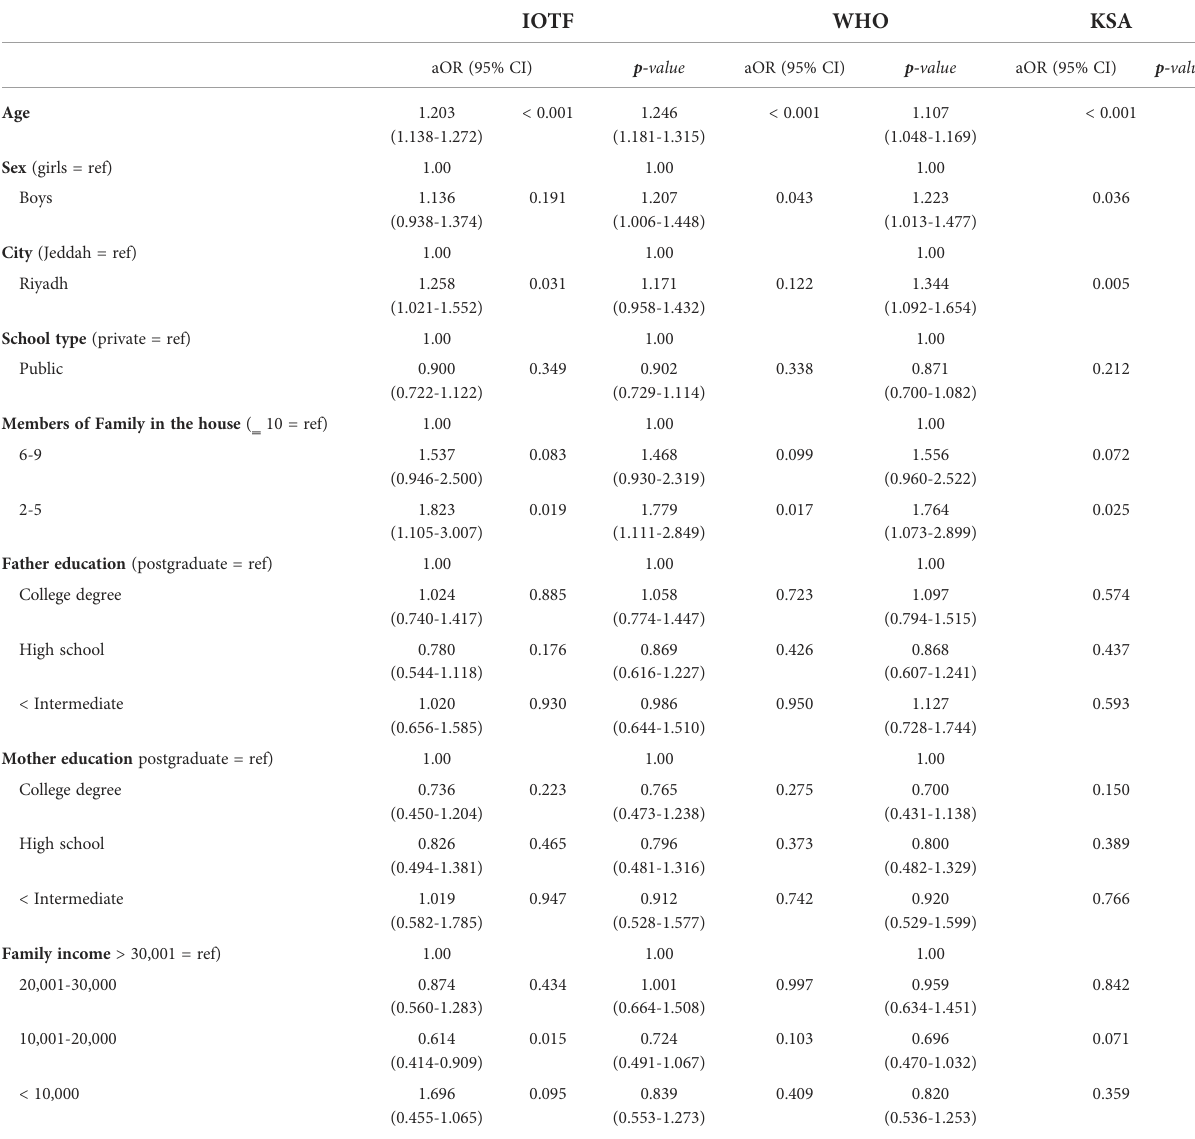
TABLE 4 Results of logistic regression analysis, adjusted for age, of selected sociodemographic variables relative to overweight/obesity versus non-overweight/non-obesity among Saudi children.